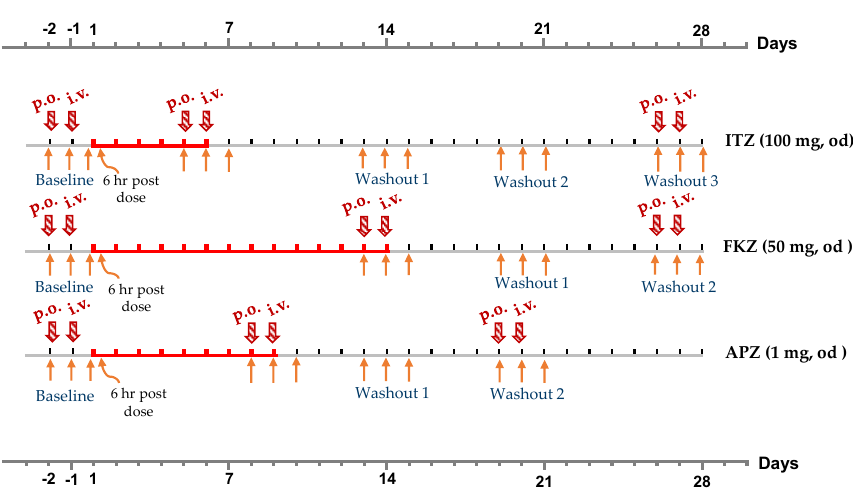
Figure 1. Study design. The red marked date indicates the ITZ/FKZ/APZ daily administration. The striped arrow indicates the MDZ AUC plasma sampling. The orange arrow indicates spot urine sampling, which was collected the morning before drug administration except for the 6 h post-dose urine collection on Day 1. (p.o.—oral administration; i.v.—intravenous administration; od—once-daily).